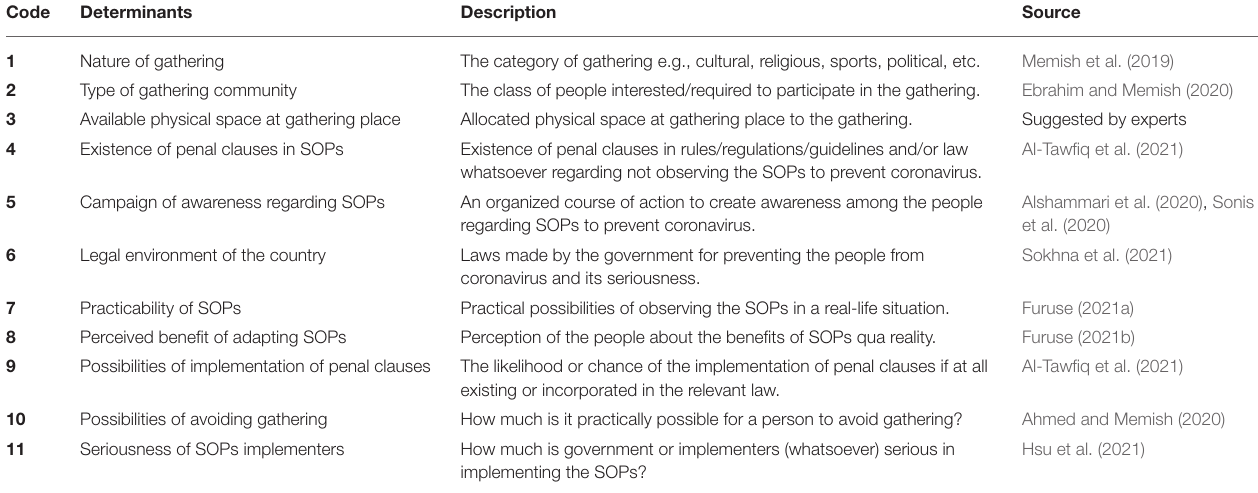
TABLE 1 | List of determinants of effectiveness of SOPs for containing